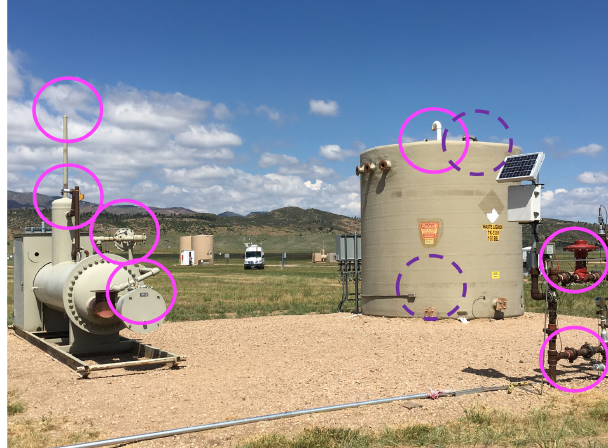
Figure 1. METEC facility with nine of the 11 release points cir- cled. Release points include (clockwise from top of tank) tank candy cane, tank thief hatch, tank front flange, wellhead Kimray packing, wellhead hand valve packing, separator burner fuel supply, separa- tor Kimray vent, separator pressure relief valve (PRV), and sepa- rator house PRV. Not pictured: wellhead lubricator flange and well- head pressure gauge. The University of Wyoming (UW) mobile lab- oratory is in the